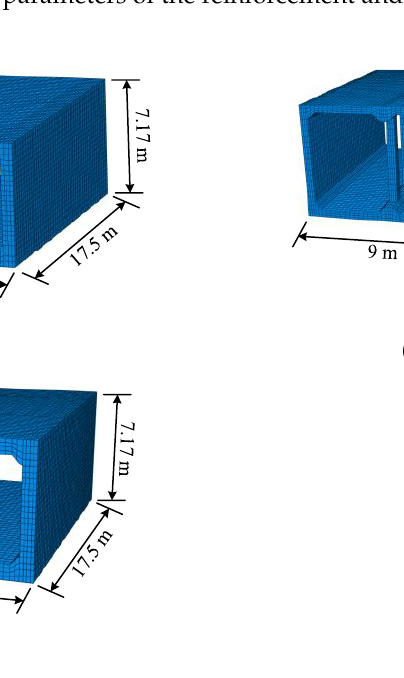
Figure 11. Finite element models of Daikai station and tunnel: ( a ) Original station; ( b ) Original tunnel; ( c ) New station.